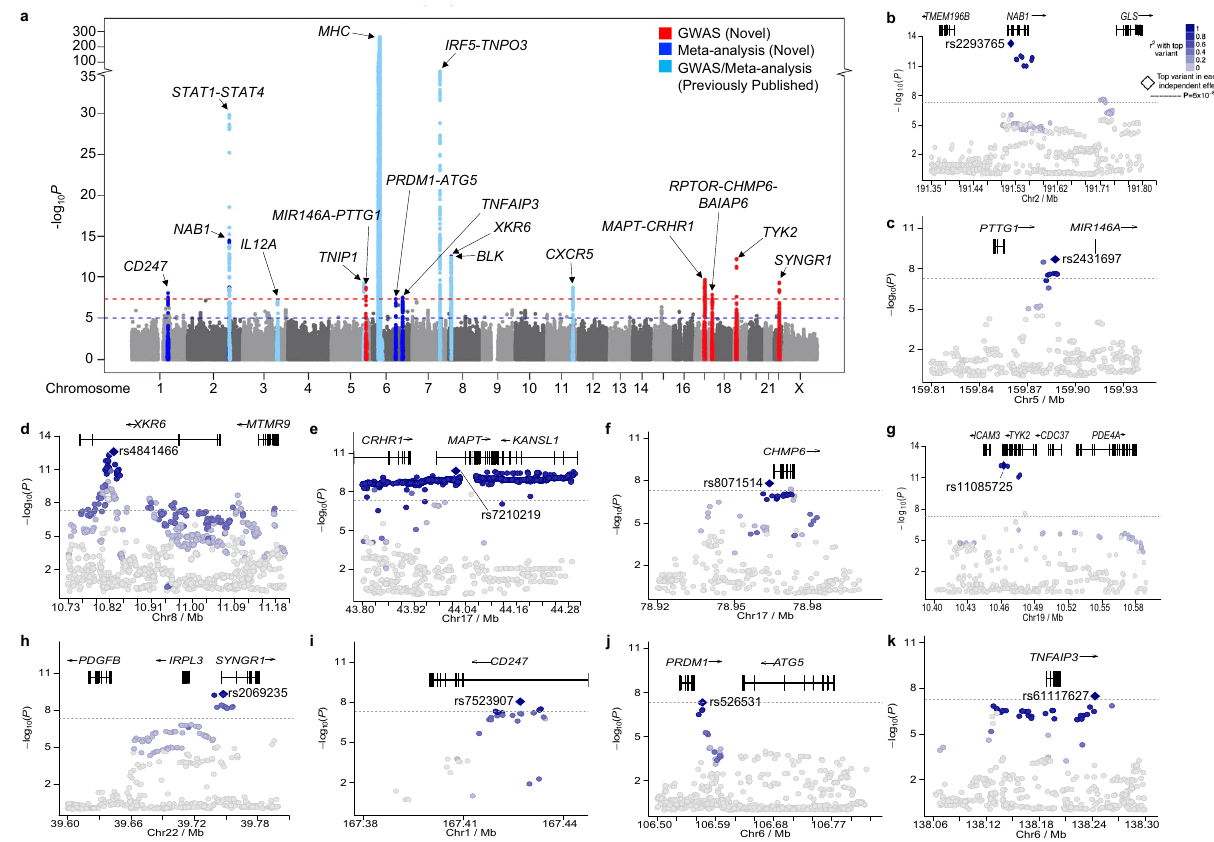
Fig. 2 Summary of the SNP-Sjögren associations in a European population. a Manhattan plot shows the summary data from the meta-analysis of the 7.3 × 10 5 SNPs shared between the GWAS and ImmunoChip dataset (Supplementary Data 1) after imputation. The − log 10 ( P ) for each variant is plotted according to chromosome and base pair position. A total of seven novel loci (indicated in red) exceeded genome-wide signi fi cance (GWS) of − 8 (red dashed line). Three additional novel loci (indicated in royal blue) exceed GWS after meta-analysis ( P P GWAS < 5 × 10 previously established loci were replicated (indicated in light blue). The suggestive GWAS and meta-analysis threshold ( P Suggestive < 5 × 10 − 5 ) is indicated by the blue dashed line. b – h Logistical regression analysis was performed on GWAS dataset PI1 after imputation, identifying the top SNP associations (e.g., index SNPs) of the novel GWS regions of association: NAB1 ( b ), PTTG1-MIR146A ( c ), XKR6 ( d ), MAPT-CRHR1 ( e ), RPTOR-CHMP6-BAIAP6 ( f ), TYK2 ( g ),